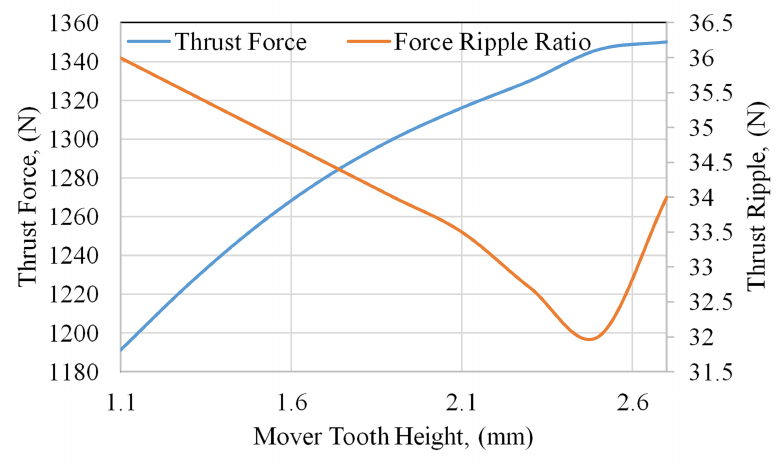
Figure 9. Force ripple and thrust force variation with mover tooth height for